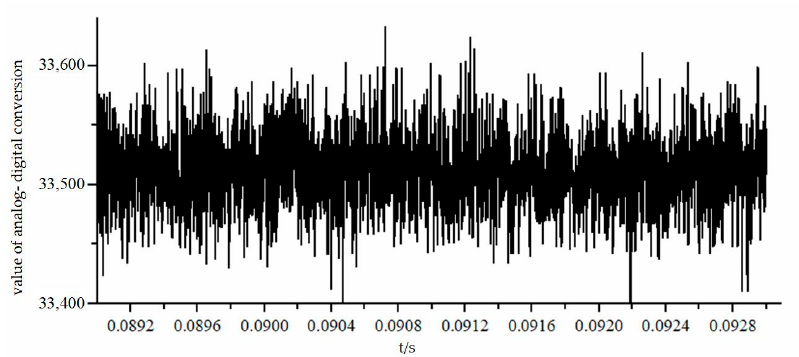
Figure 5. Result of noise sampling.